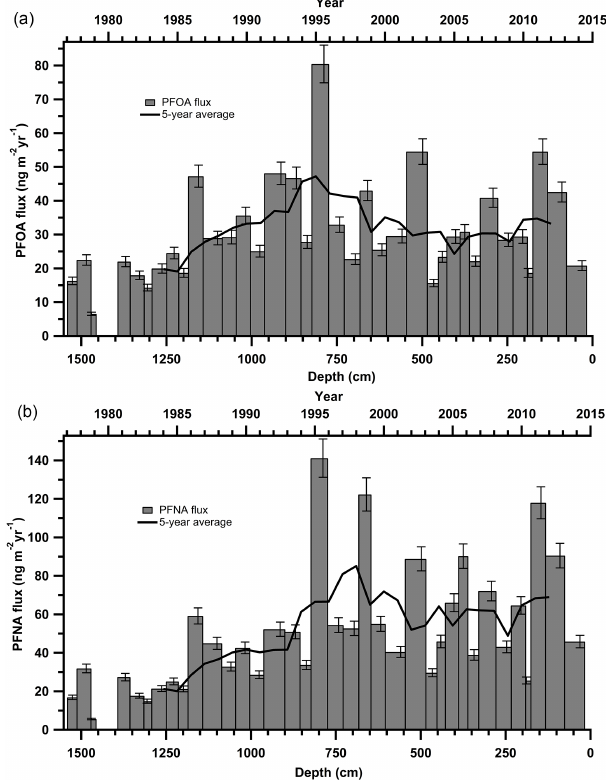
Figure 2. Annual deposition fluxes on the Devon Ice Cap: (a) PFOA and (b) PFNA. The solid black line represents the 5-year moving